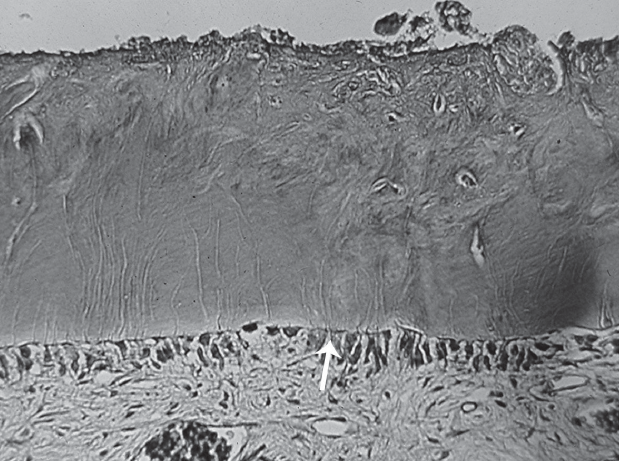
Fig. 6 - (group II; 60th day) - Presence of a large hard tissue barrier. Odontoblastic like cells are organized in layer (arrow) and absence of inflammatory characteristics in the connective tissue. Masson Trichrome stain, original magnification 125X.